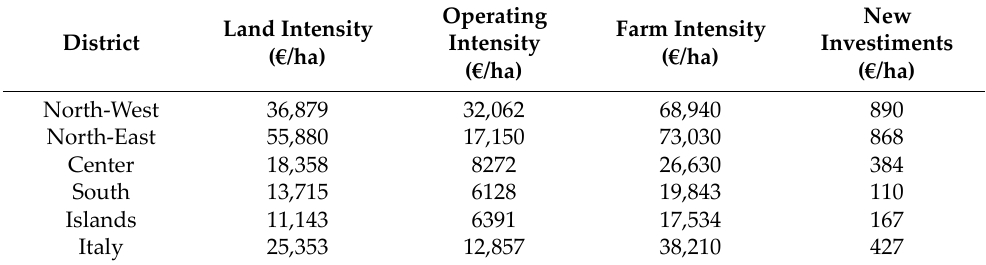
Table 3. Small farms investments by district.